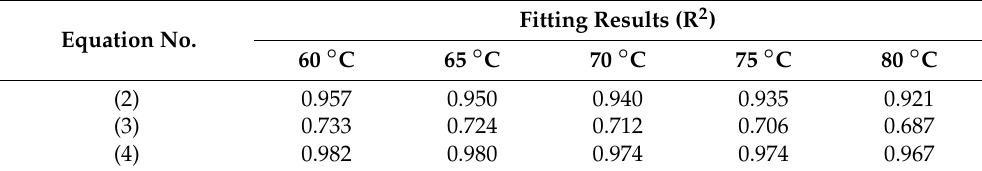
Table 2. SCM equation fitting for Sc extraction from RMF. Equation No.